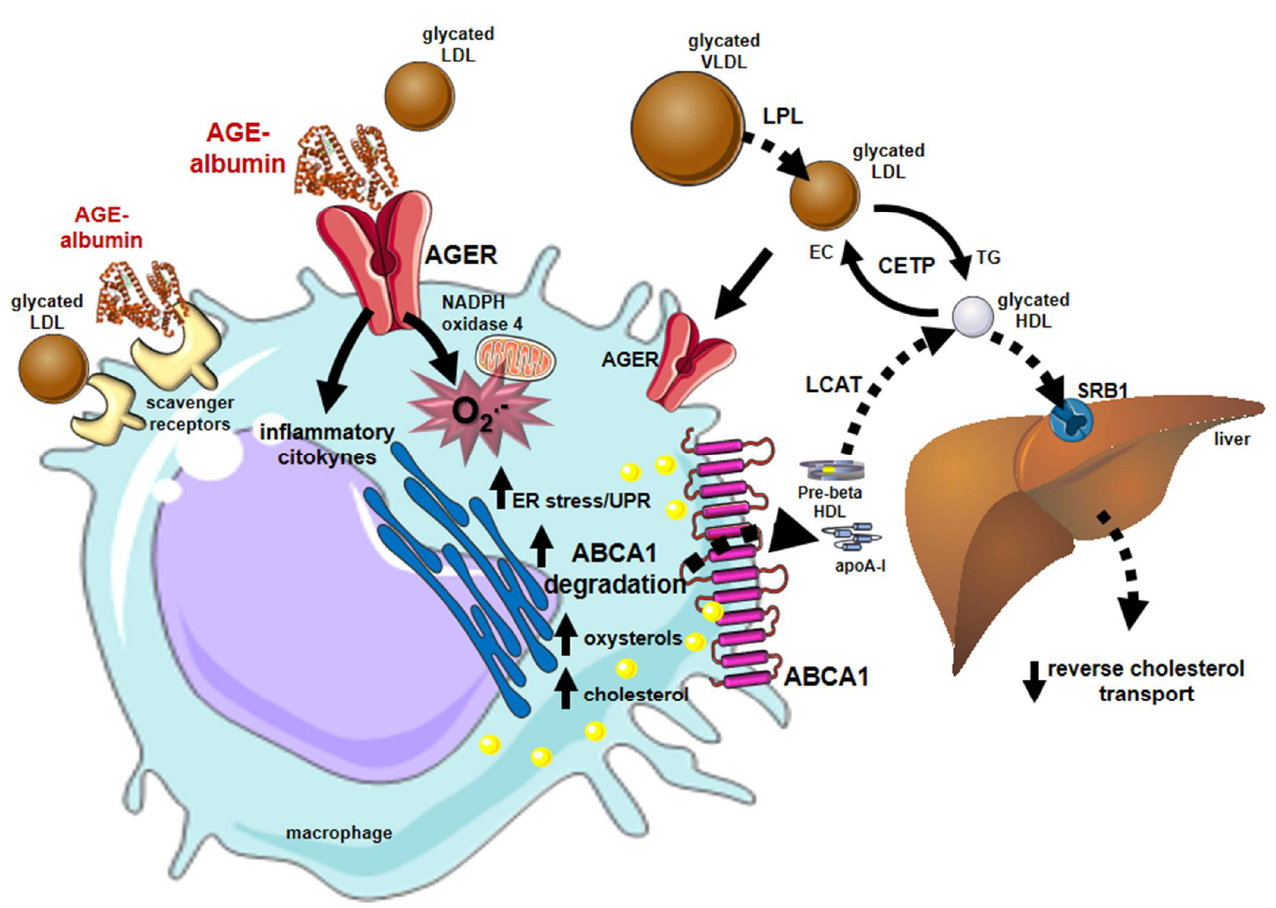
Figure 4. Major influences of glycation on lipid metabolism and reverse cholesterol transport that favor atherogenesis. Alterations in lipid and lipoprotein metabolism induced by early and advanced glycation favor atherogenesis. In blood circulation, the lipolysis of chylomicrons and VLDLs by the lipoprotein lipase (LPL) is damaged by glycation, inducing plasma triglycerides elevation. The activity of CETP is also stimulated between glycated lipoproteins enabling more cholesterol to be transferred from HDLs to atherogenic lipoproteins and reducing HDL cholesterol. Glycated LDLs are taken up by macrophage scavenger receptors and by the advanced glycosylation end product- specific receptor (AGER). Advanced glycated albumin (AGE-albumin) induces, via AGERs, oxidative stress by enhancing the activity of NADPH oxidase 4 and mitochondrial systems and inflammation. Together, oxidative stress and inflammation lead to ER stress that triggers proteasomal and lysosomal degradation of the ABCA-1 compromising the cholesterol efflux to apo A-I and the generation of HDLs. The activity of (LCAT) is impaired by HDL glycation reducing the lipoprotein maturation. The accumulation of cholesterol and toxic oxysterols in macrophages triggers oxidation, inflammation, and ER stress creating a vicious circle that contributes to atherogenesis, plaque instability, and rupture. Parts of the figure were drawn using Servier Medical Art (https://smart.servier.com/, accessed on 14 December